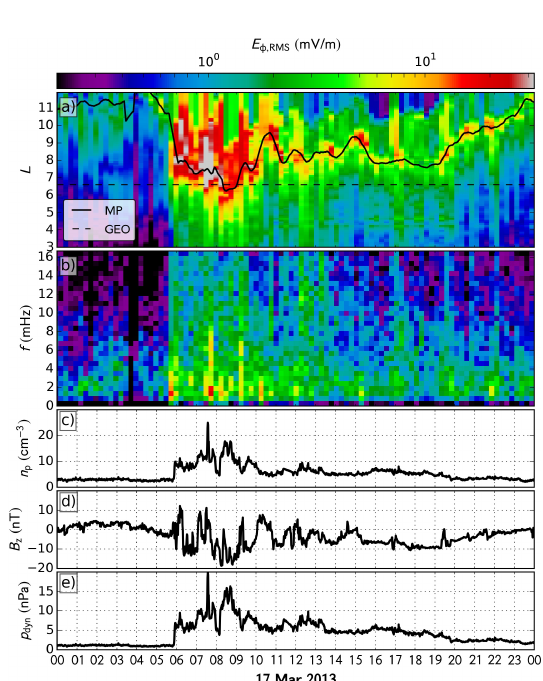
Figure 2. Power spectrum analysis for 17 March 2013 storm. The figure follows the same format as Fig.